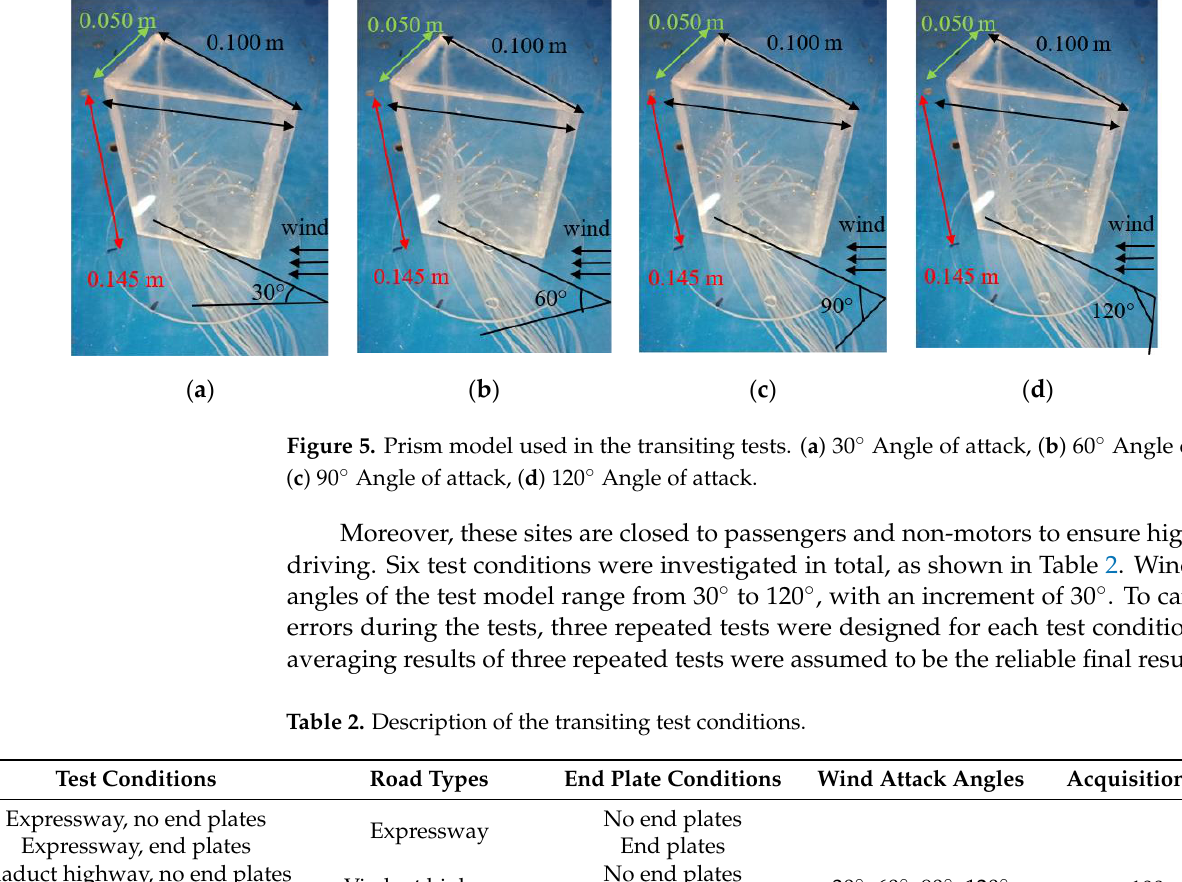
Table 2. Description of the transiting test conditions.